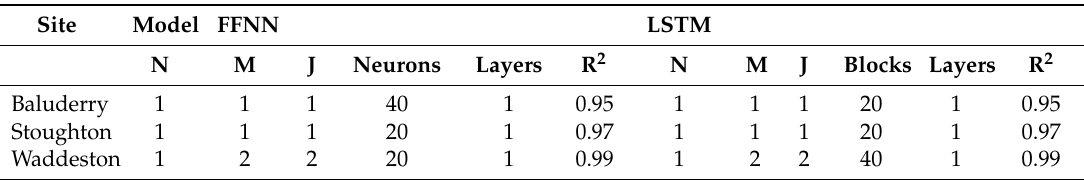
Table 4. The identified model structure with the best one-day-ahead prediction performance across the training sites.